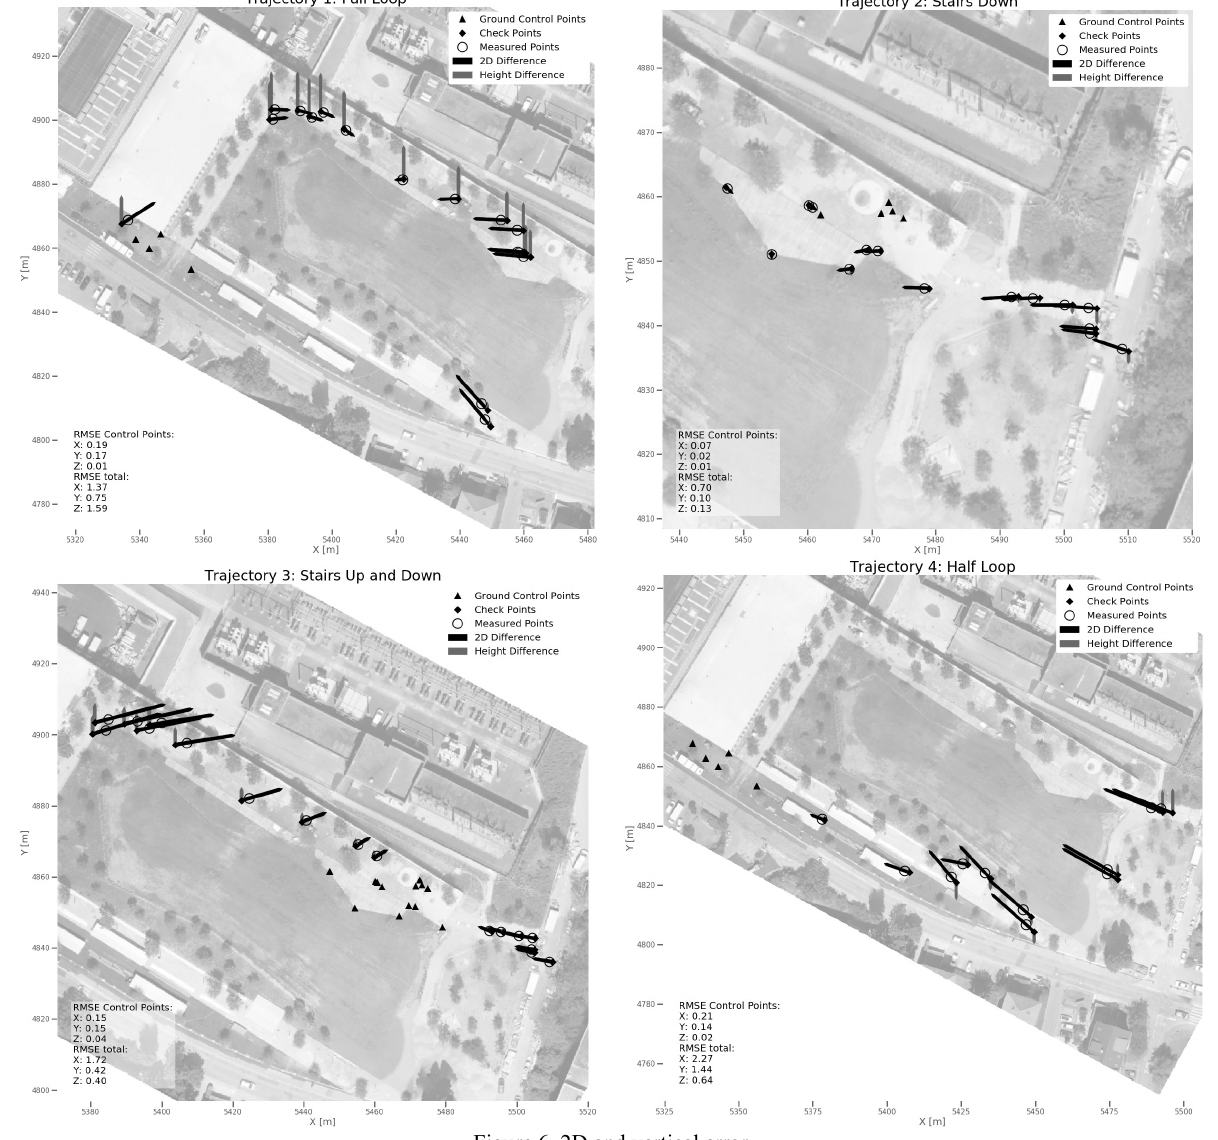
Figure 6. 2D and vertical error (top left: trajectory one, top right: trajectory two, bottom left: trajectory three, bottom right trajectory